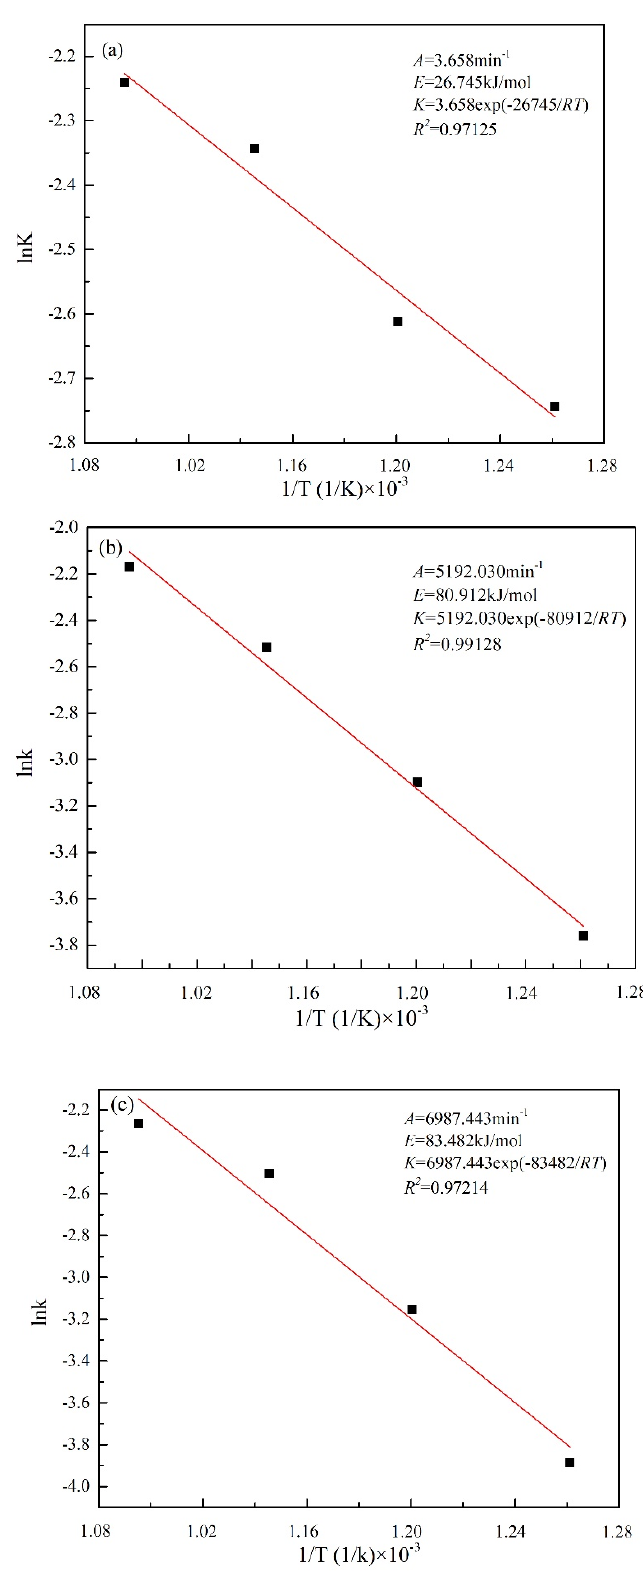
Figure 7. Arrhenius plot for the evaluation of the activation energy of the process (a) 0% NaOH, ( b ) 1% NaOH, ( c ) 2%